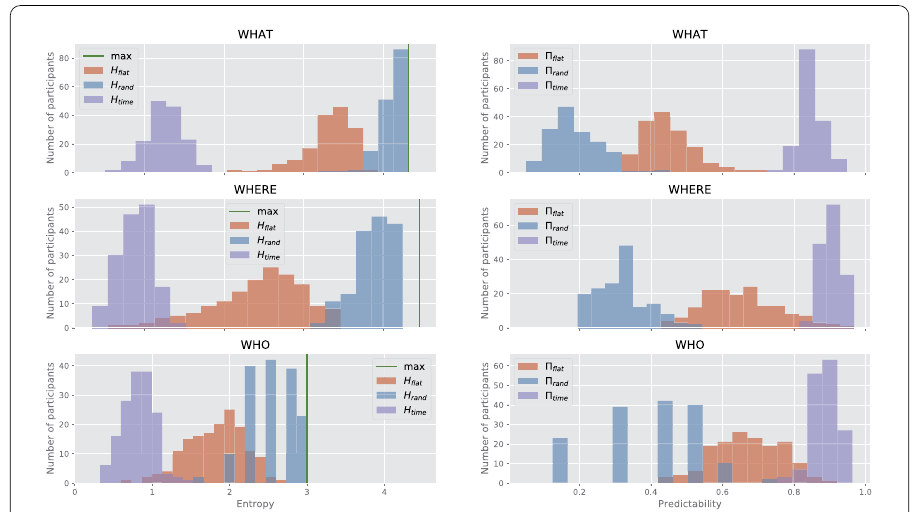
Figure 5 Empirical distribution of entropy (left) and corresponding predictability (right). From top to bottom: WA, WE, and WO. The bar height indicates the number of participants. The green bar indicates the maximum possible